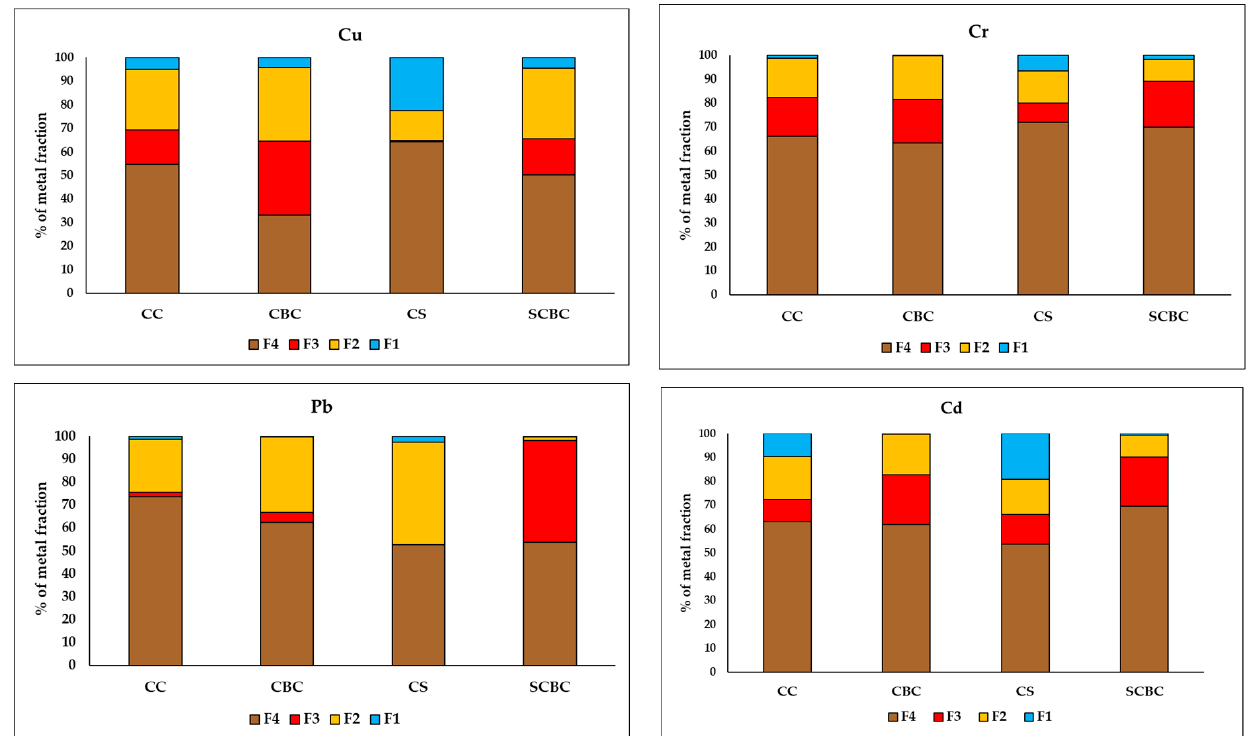
Figure 3. Effects of the application of rabbit manure biochar and co-application of rabbit manure biochar with compost on the speciation of heavy metals (Cu, Cr, Cd and Pb) in compost (CBC) and soil (SCBC) compared with untreated compost (CC) and soil (CS).